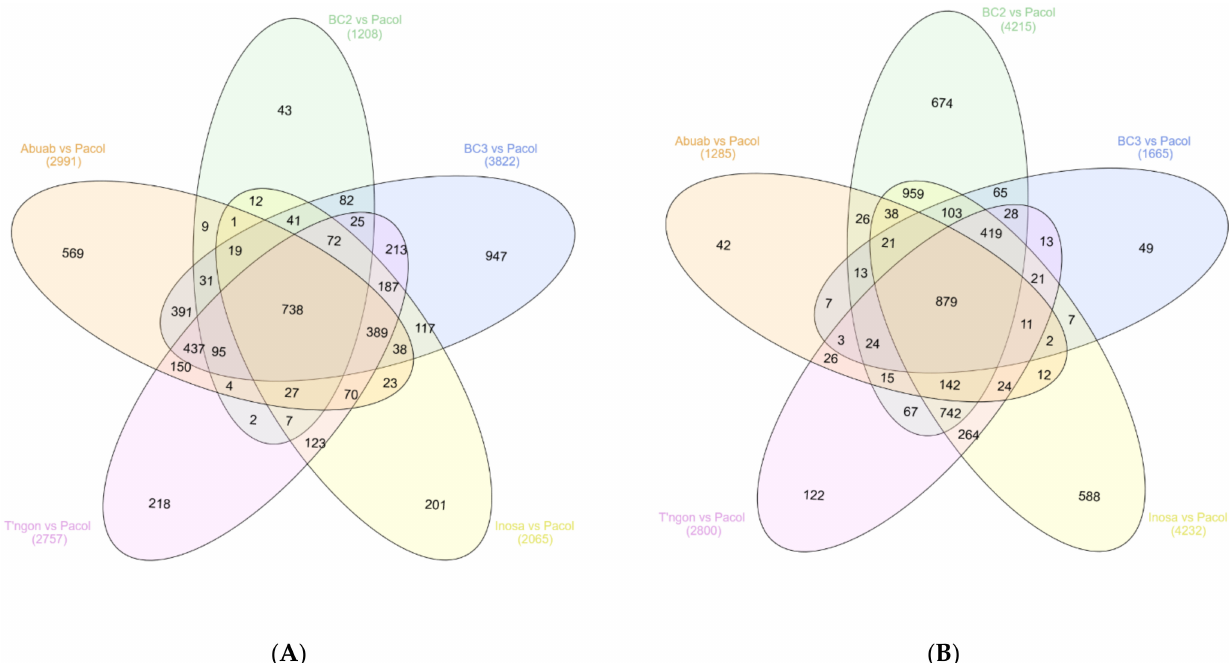
Figure 5. Commonly ( A ) up- and ( B ) down-regulated transcript orthologs between abaca variety and Pacol. Each ellipse represents the number of differentially expressed transcript orthologs between an abaca genotype and Pacol. Figure generated using InteractiVenn